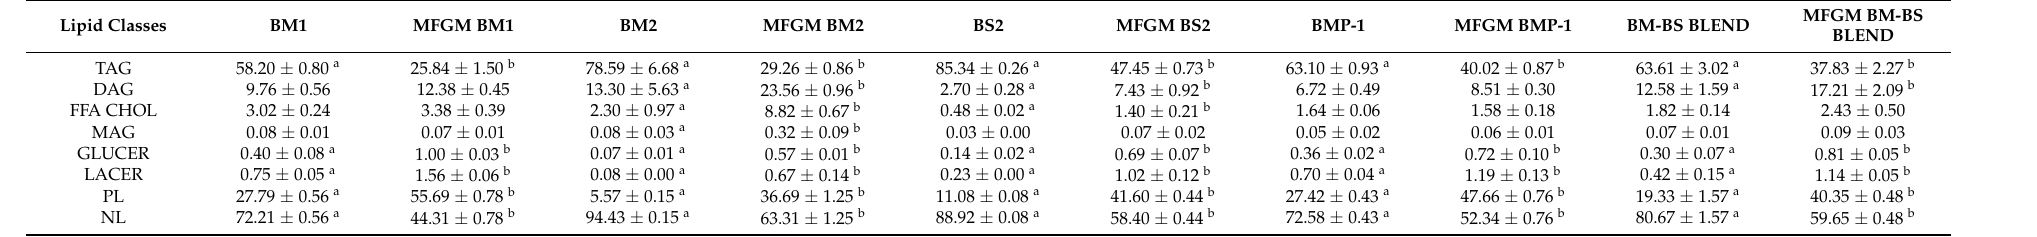
Table 4. Mean values of the lipid class profile of the selected samples and their corresponding MFGM